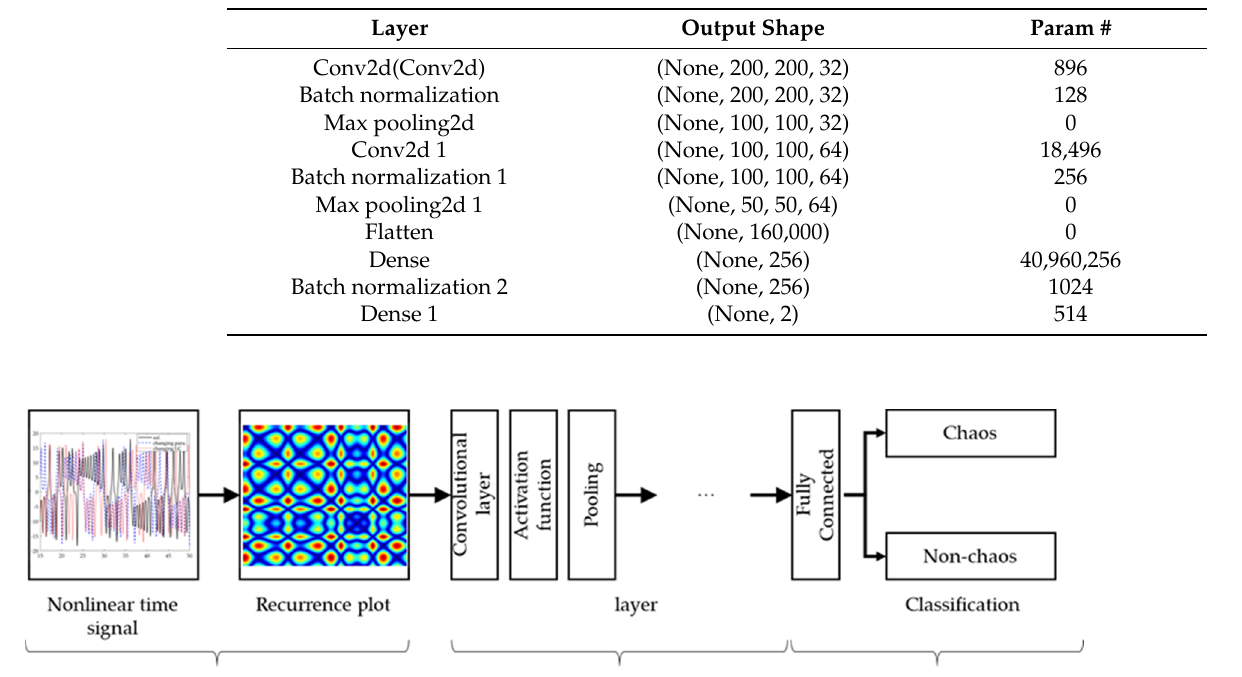
Table 1. CNN model for the Lorenz system.